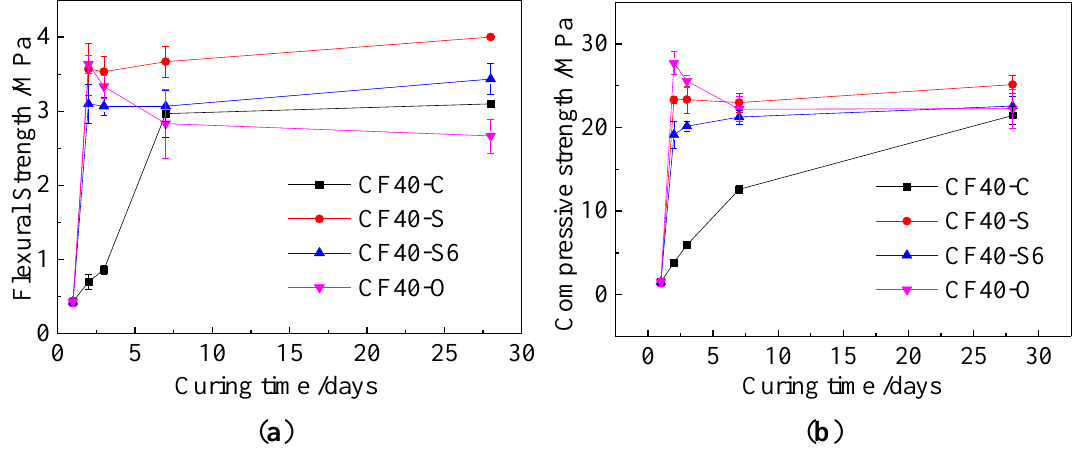
Figure 2. Effect of curing conditions on strength of Class C fly ash geopolymer at W/F0.40. ( a ) Flexural strength; and ( b ) compressive